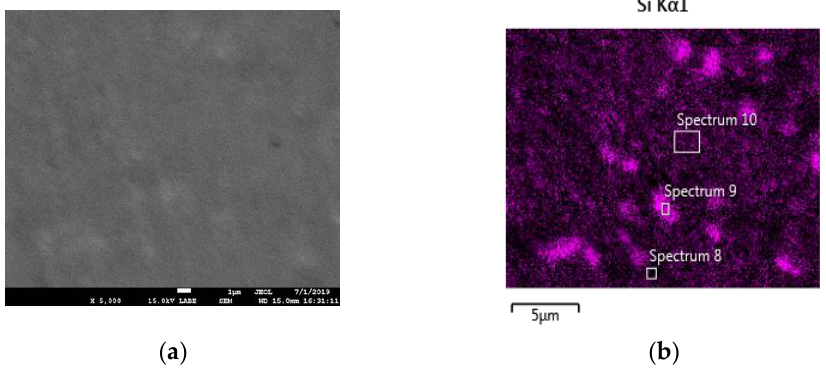
Figure 6. ( a ) SEM image without metallographic attack and ( b ) EDS Si map of the 2 h-400 specimen. (XZ specimens).